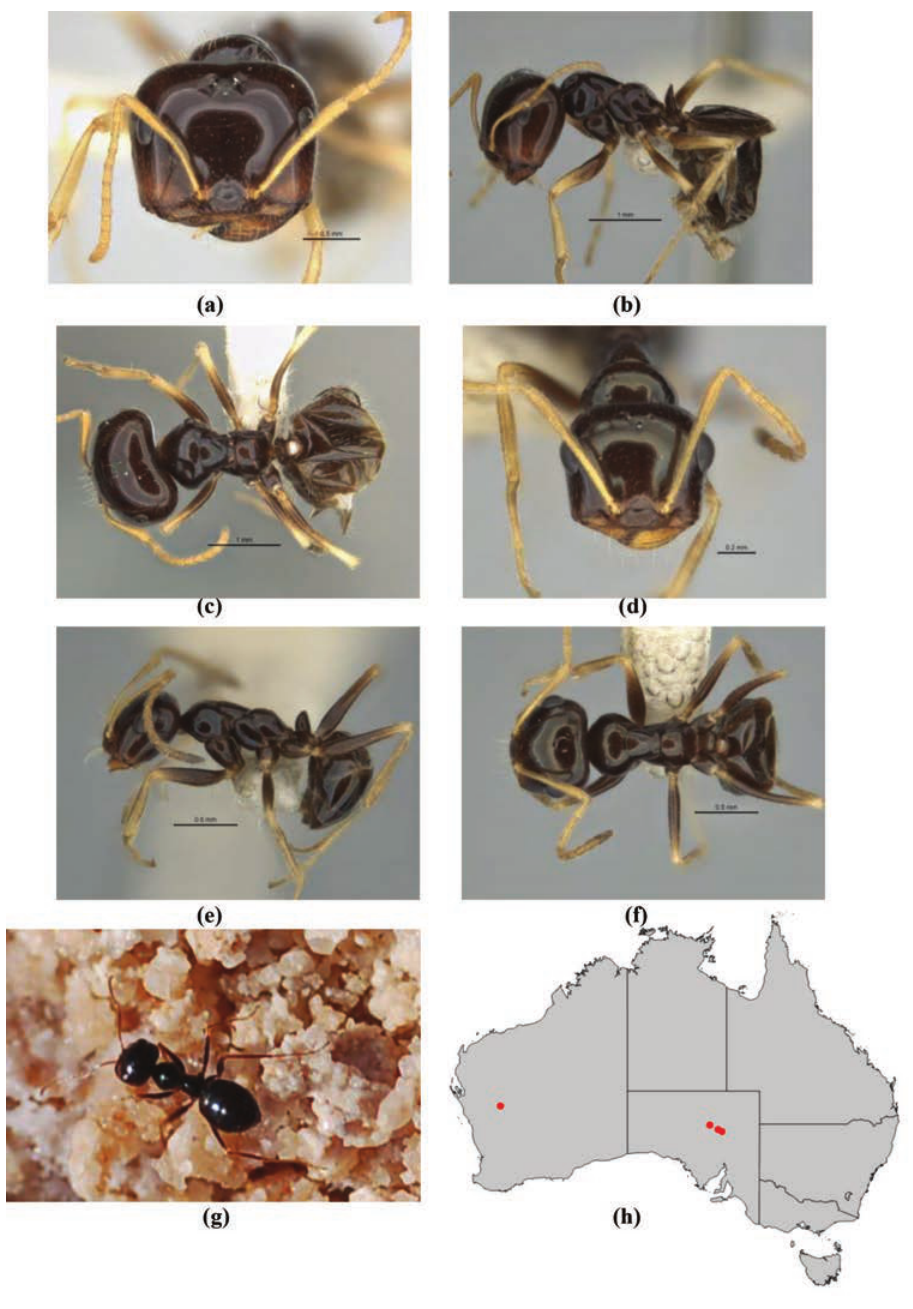
Figure 49. Melophorus marmar sp. n.: major worker paratype (ANIC32-900054–top ant) frons ( a ), profile ( b ) and dorsum ( c ); minor worker holotype (ANIC32-900054–bottom ant) frons ( d ), profile ( e ) and dorsum ( f ); Melophorus marmar forager on the dry surface of Lake Austin ( g ); distribution map for the species ( h ). Low resolution scale bars: 1 mm ( b, c ); 0.5 mm ( a, e, f ); 0.2 mm